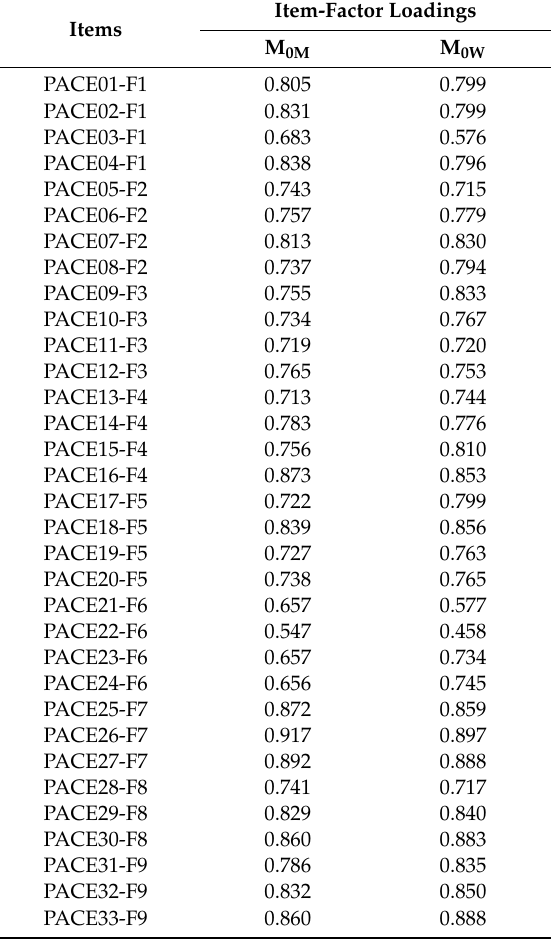
Table 6. Item-factor loadings in the baseline models for men and women.